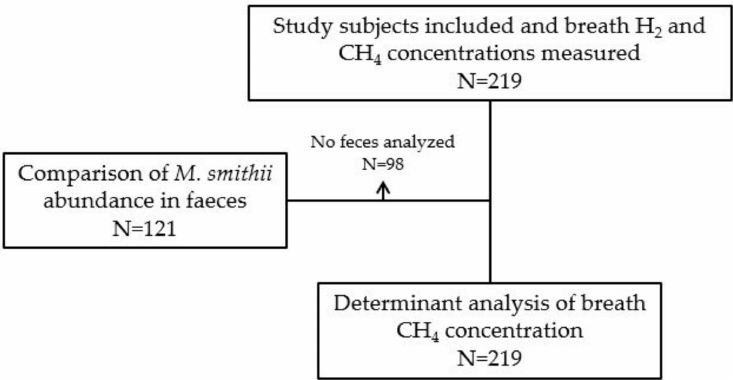
Figure 1. Consortflowdiagram. Abbreviations: CH 4 , methane; H 2 , hydrogen; M.smithii , Methanobrevibacter